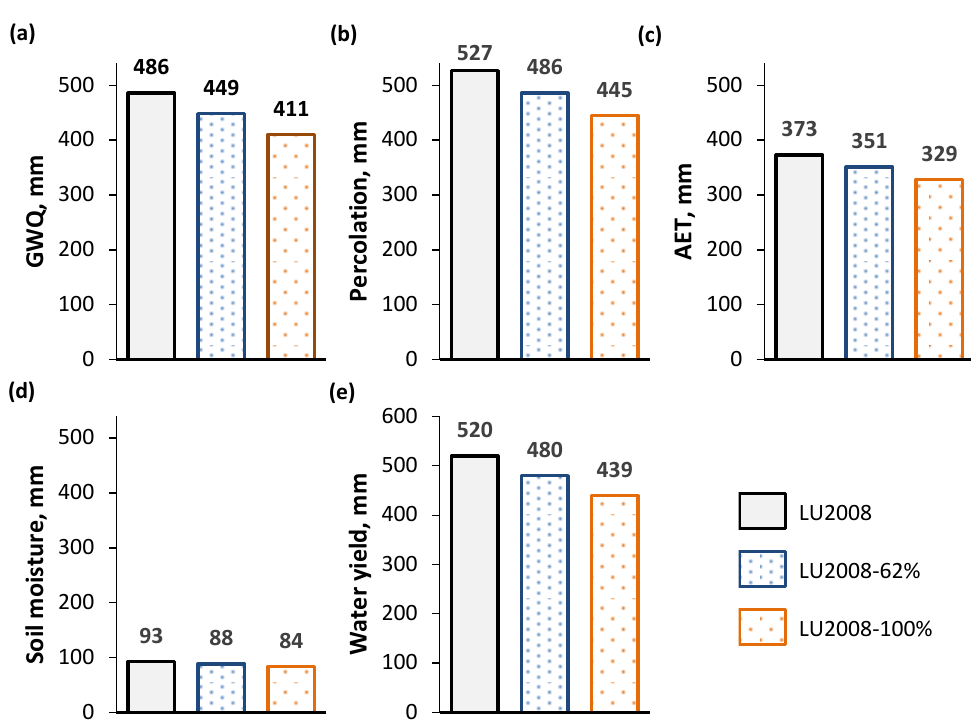
Figure 9. Water balance components: groundwater contribution to streamflow, GWQ ( a ), percola- tion ( b ), AET ( c ), soil moisture ( d ), and water yield ( e ) estimated for the observed land use pattern (LU2005) and under 62% (LU2005-62%) and 100% (LU2005-100%) afforestation scenarios in 2005, representing average conditions.